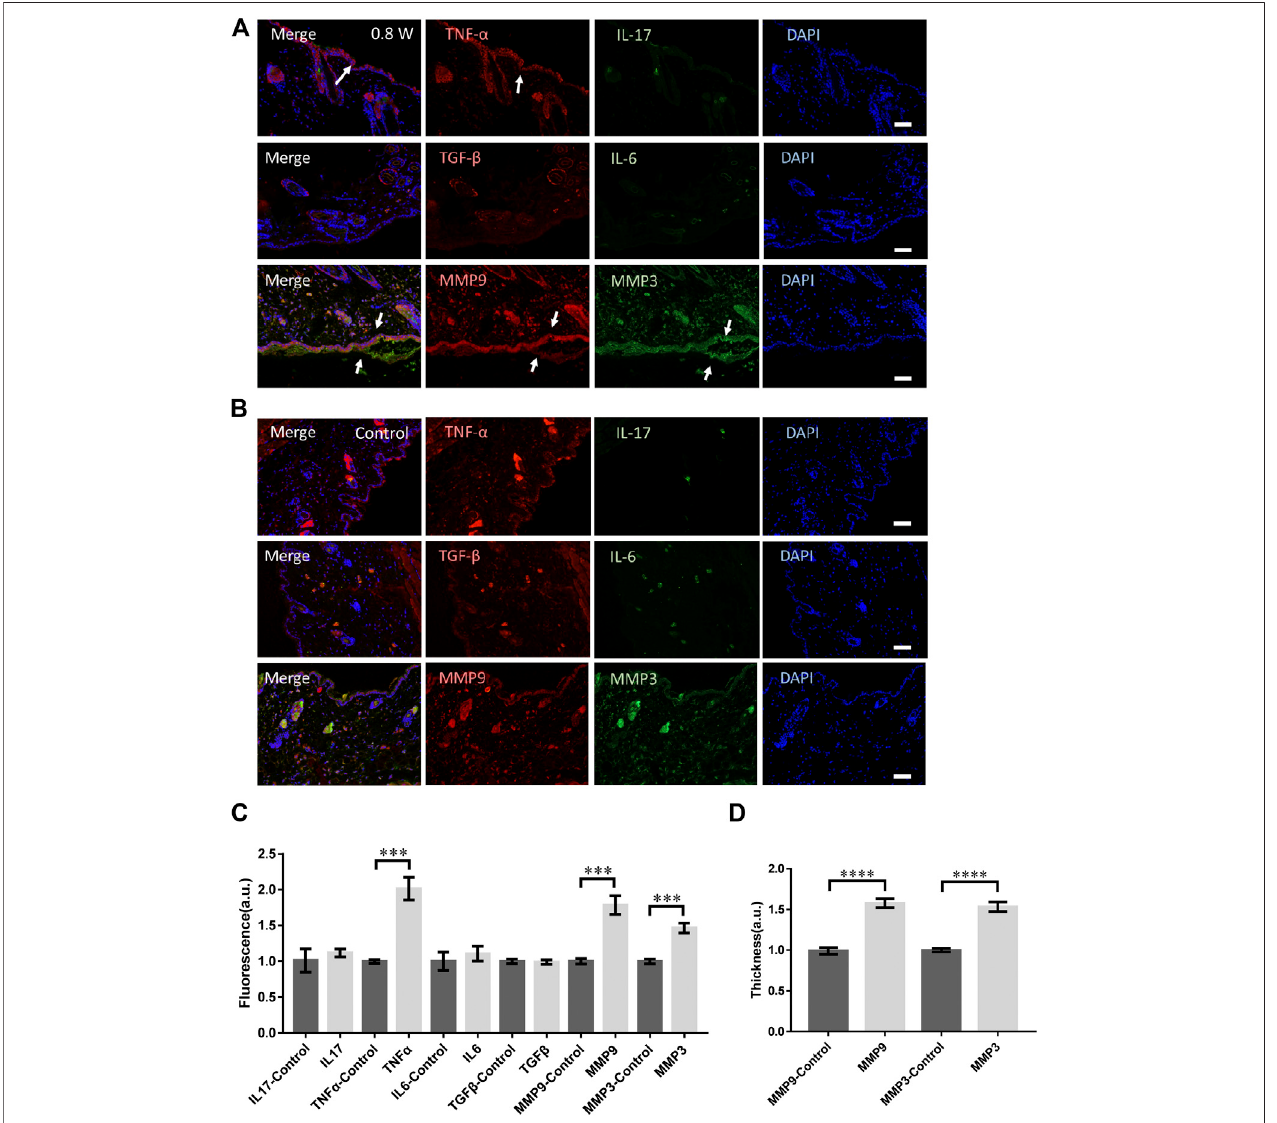
FIGURE 3 | The molecular responses to the laser micromachining after one-day recovery. The immuno fl uorescence of the skin treated at 0.8 W after one-day recovery (A) and the control (B) respectively. (C) The statistics of the fl uorescence intensity of each molecule with immune-staining. (D) The skin thickness with MMP3 and MMP9 positive. n (cid:1) 12 samples from four independent trails. Bar: 100 μ m. * p < 0.05. ** p < 0.01. *** p < 0.001. **** p < 0.0001, by students ’ t-test .